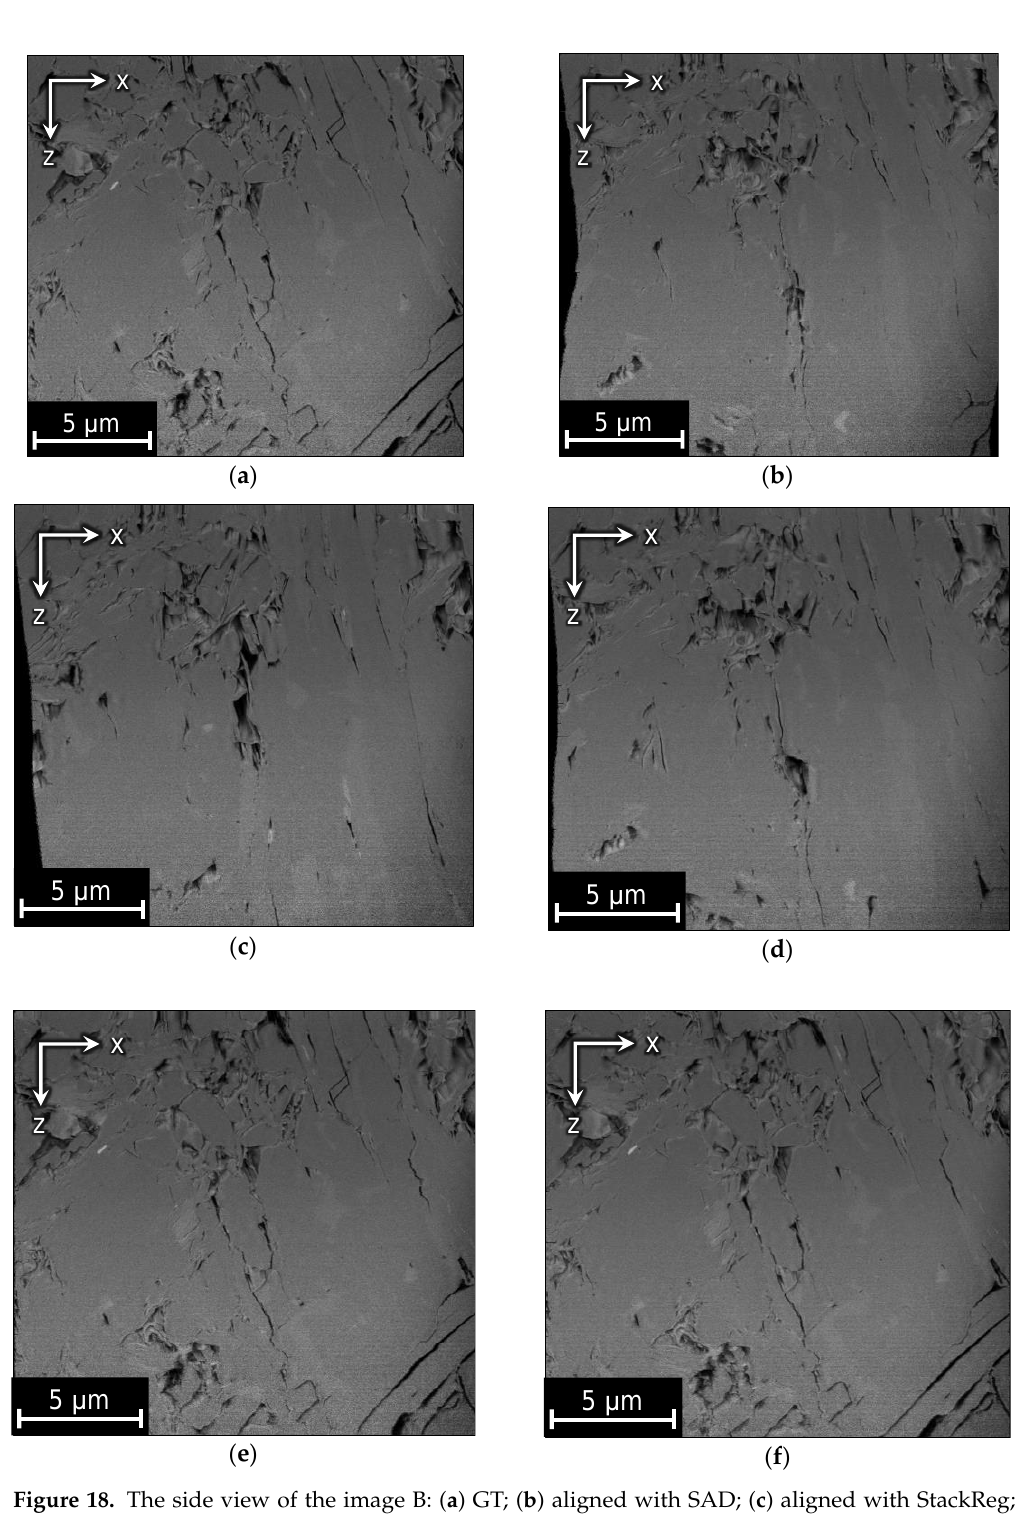
Table 4. Alignment metrics for image B.